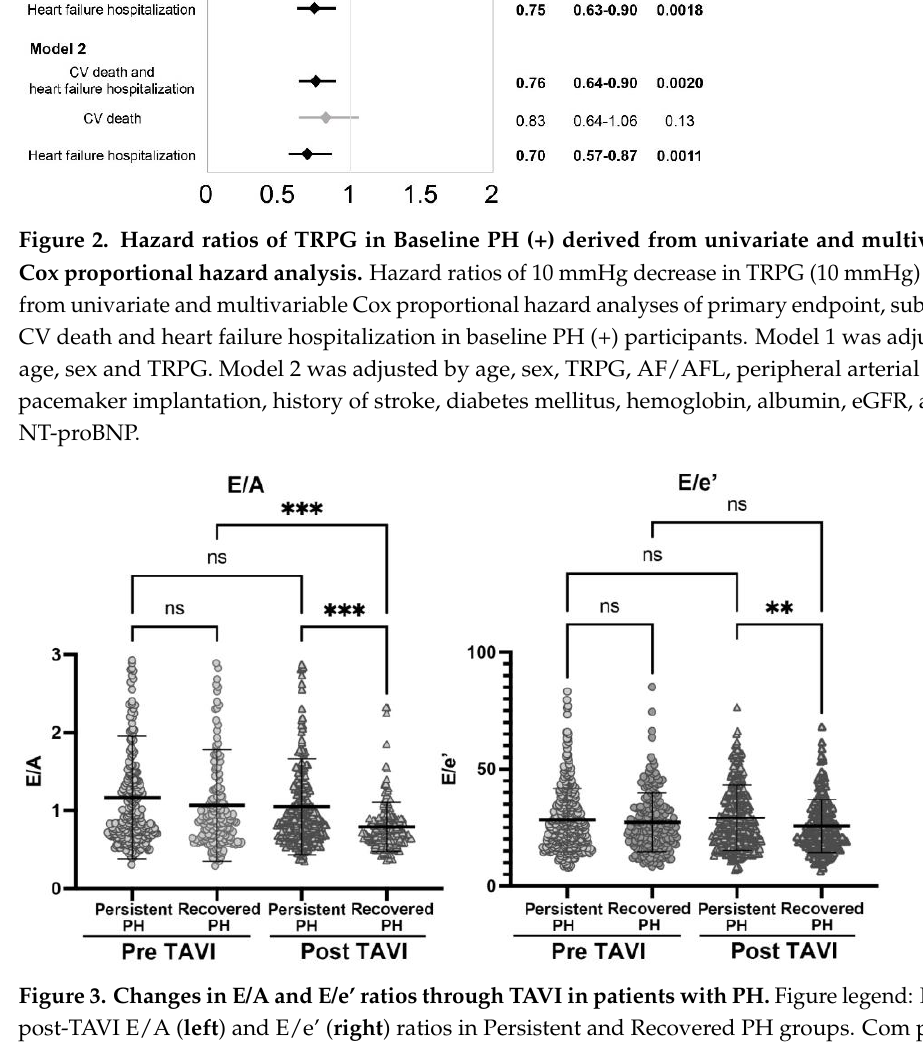
Figure 2. Hazard ratios of TRPG in Baseline PH (+) derived from univariate and multivariable Cox proportional hazard analysis. Hazard ratios of 10 mmHg decrease in TRPG (10 mmHg) de- rived from univariate and multivariable Cox proportional hazard analyses of primary endpoint, subsequent CV death and heart failure hospitalization in baseline PH (+) participants. Model 1 was adjusted by age, sex and TRPG. Model 2 was adjusted by age, sex, TRPG, AF/AFL, peripheral arte- rial disease, pacemaker implantation, history of stroke, diabetes mellitus, hemoglobin, albumin, eGFR, and Log NT-proBNP.